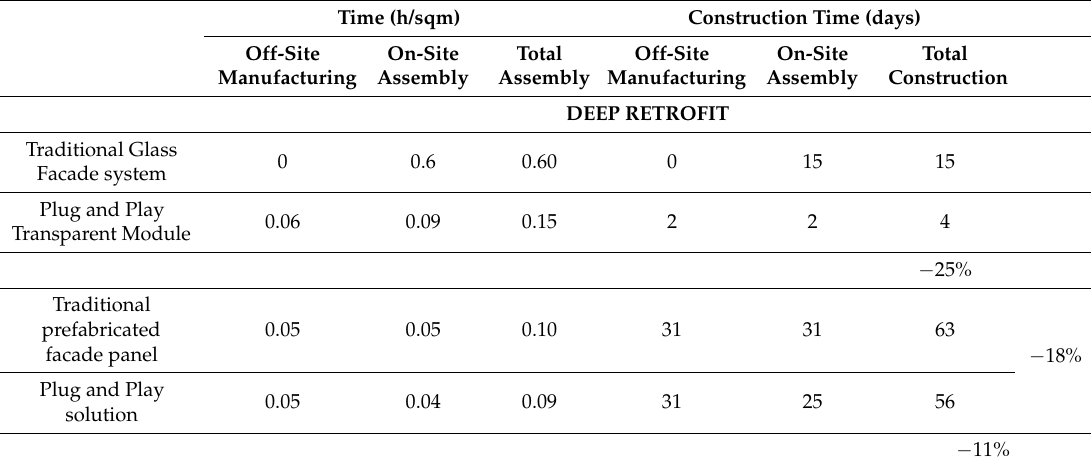
Table 1. Estimation of reduced construction time of pre-fabricated solution compared to state-of-the-art deep renovation practices. Time (h/sqm) Construction Time (days) Off-Site